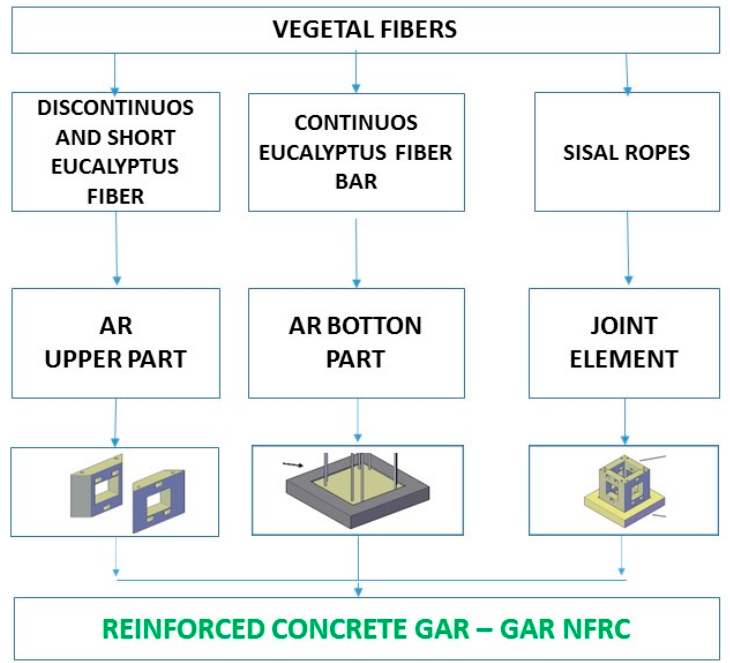
Figure 4. Detail of the concrete reinforcement at the bottom and upper parts of AR, using 100% vegetable fibres. GAR: green artificial reef. NFRC: natural fibre-reinforced concrete.